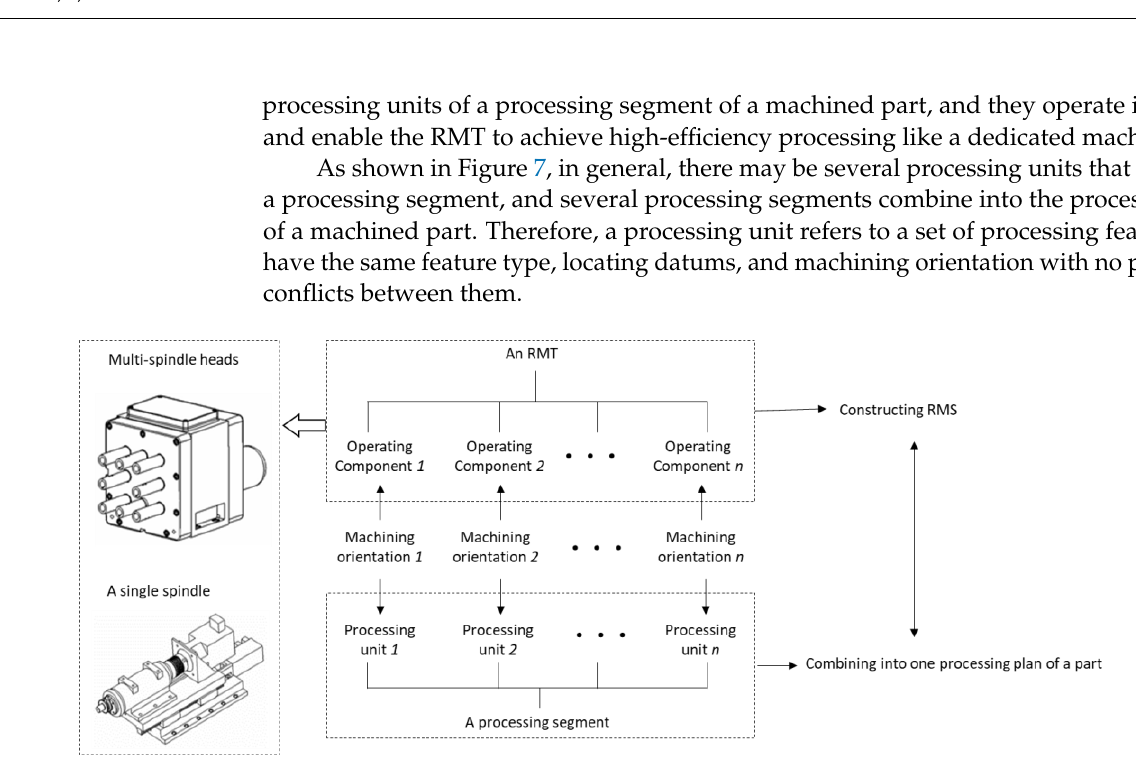
Figure 7. Mapping relationship between the part’s processing plan and the reconfigurable manufacturing system.